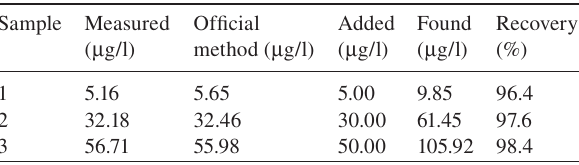
-P in seawater by the proposed 4